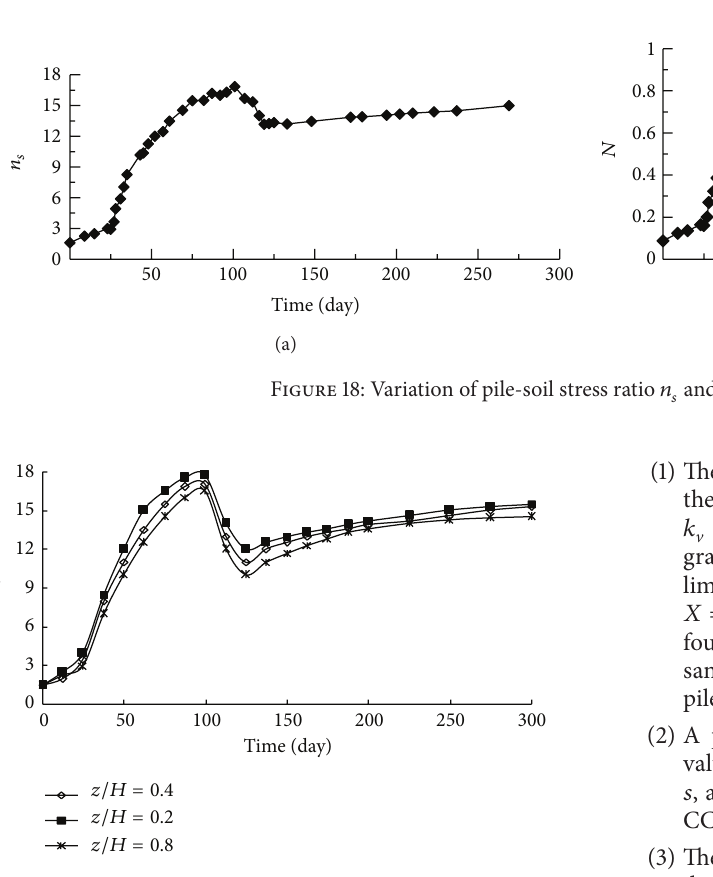
Figure 19: Variation of pile-soil stress ratio 𝑛 𝑠 obtained by theoreti- cal